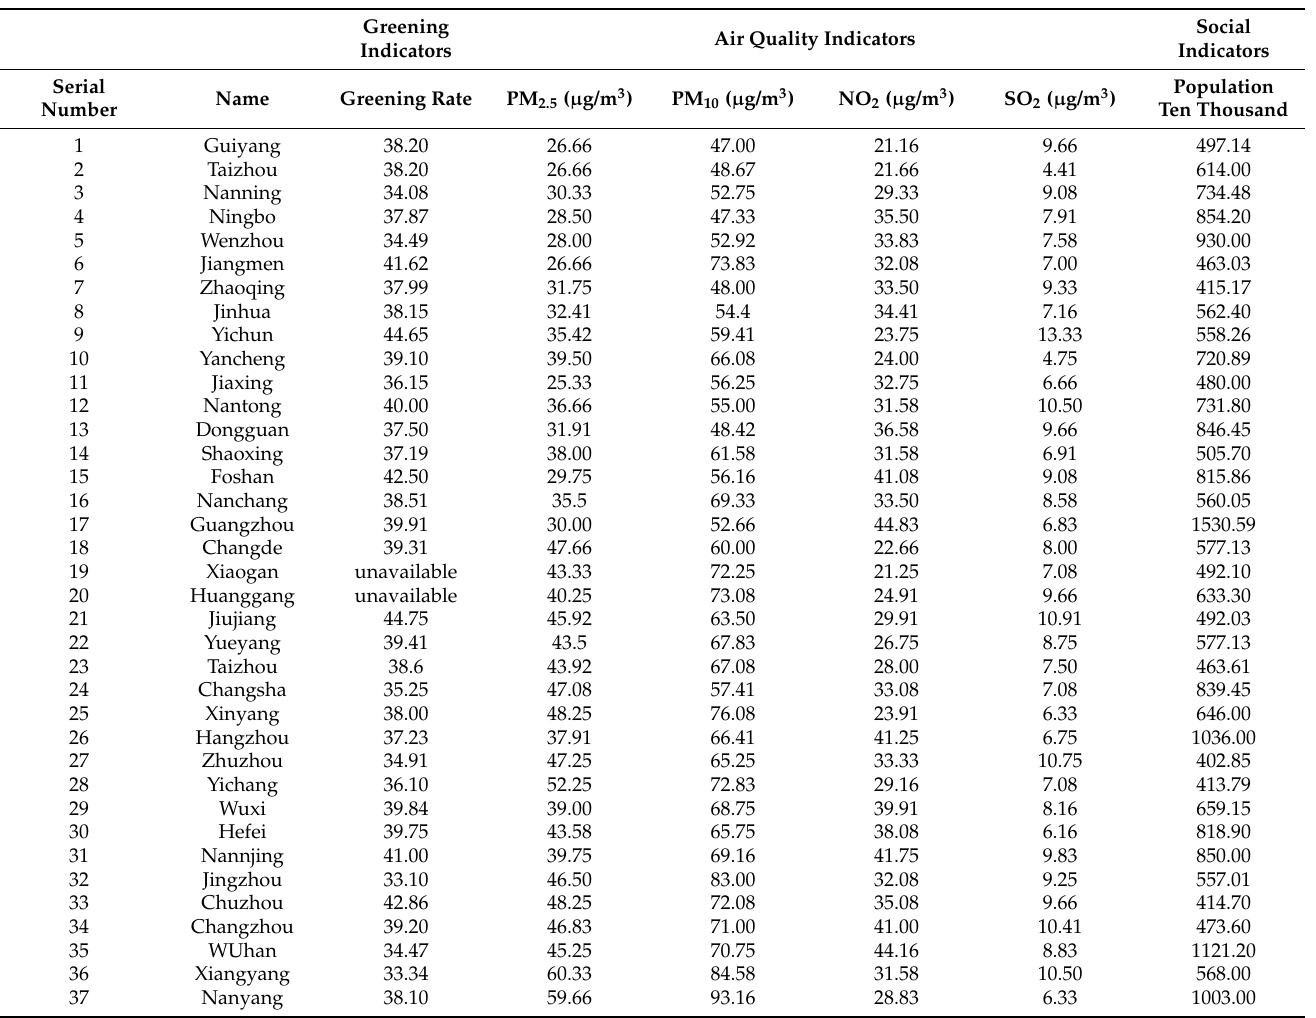
Table A1. The effect of landscape patterns of urban green spaces on air pollution